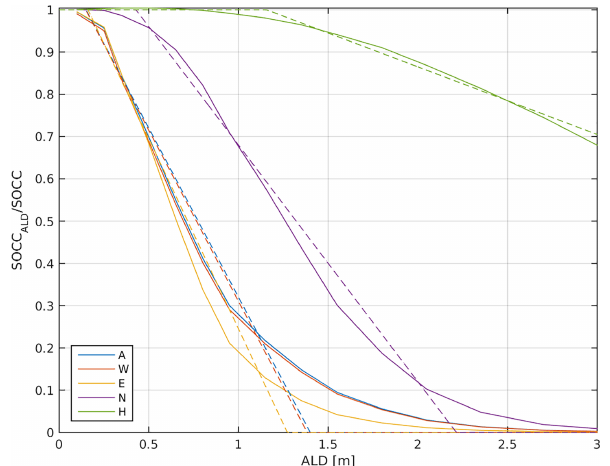
Figure A12. Dependency of vertical soil carbon concentration at the permafrost table on active layer depth (ALD) as simulated by the process-based SOM transport model. The ratio of equilibrium SOCC at the ALD SOCC i to mean seasonally thawed SOCC i ALD is shown for individual soil carbon lability pools. Values smaller than 1 are indicative of SOCC declining with depth. Dotted lines illustrate linear approximations used for implementation into JS- BACH. Curves are inferred for default parameters of the process- based SOM transport model (cryoturbation rate: 10cm 2 yr − 1 , sedi- mentation rate: 10cmkyr − 1 , litter input described by grassland).